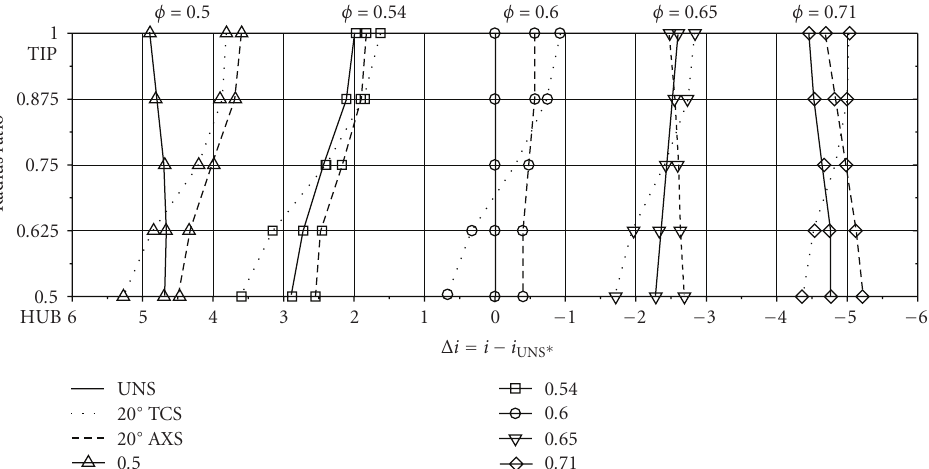
Figure 4: Change in incidence.